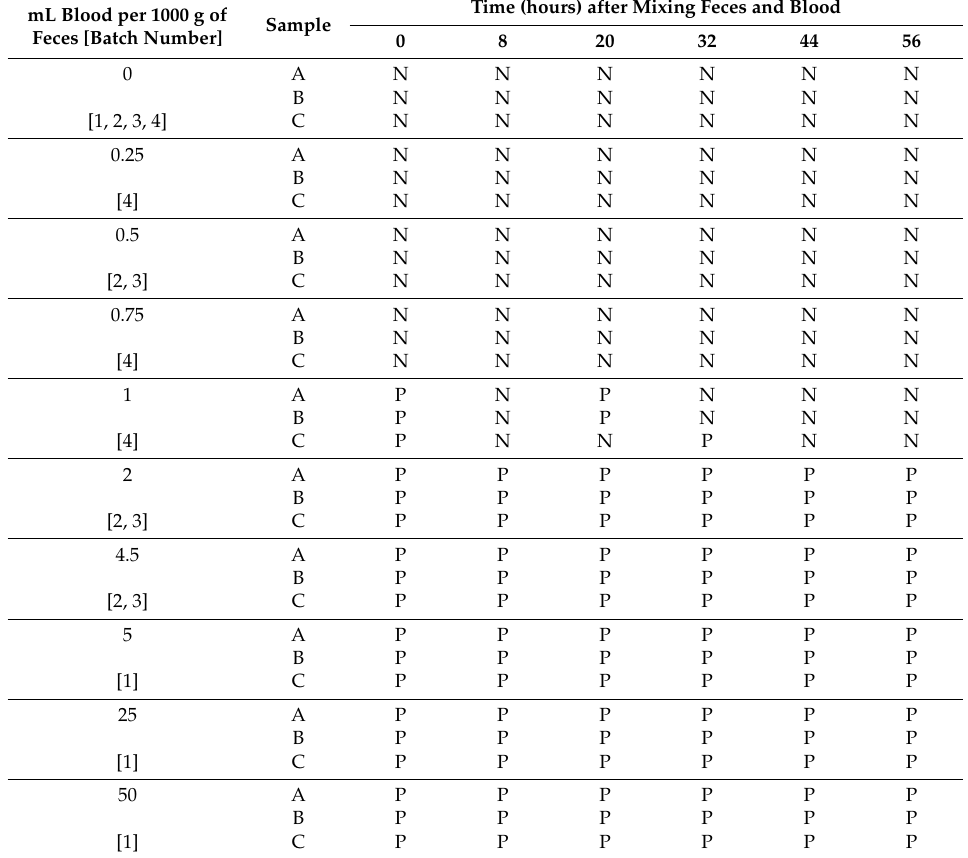
Table 2. The experimental in vitro setup testing the analytical detection limit of bovine blood in bovine fecal matter in di ff erent titrations tested with Hemo-Fec ® . The letters A, B and C are the repeated samples made from each mixture of feces and whole blood (sub-batches), and the letters “N” and “P” represents the negative and positive samples, respectively. Batches 1 and 2 were comprised of feces from two cows whereas batch 3 and 4 were made with feces form one cow. Batch 2 and 3 were equal in both blood volumes and results, hence they were shown as one result. Likewise, the four sub-batches with 0 mL of blood added are shown as one